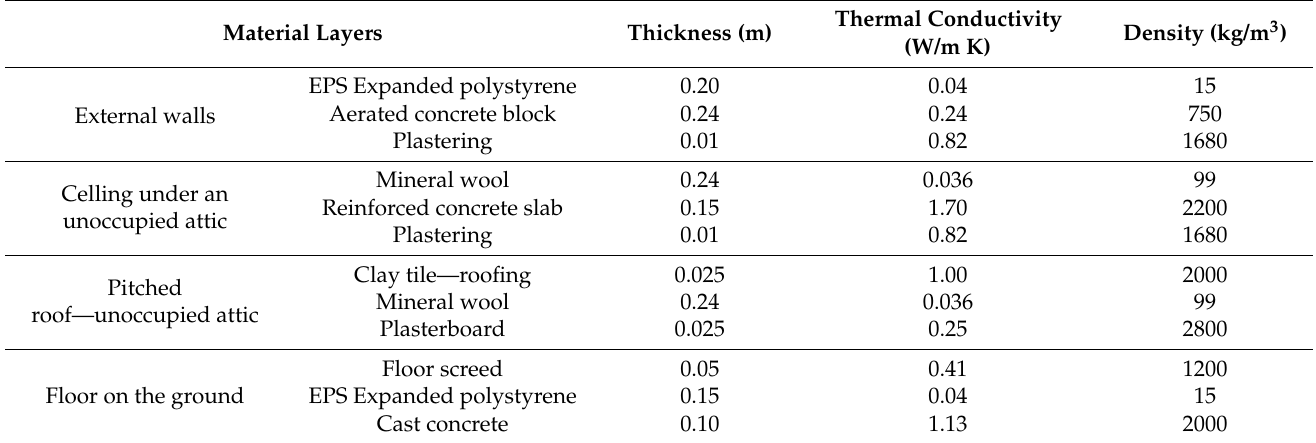
Table 2. Thermal properties of materials of components in the buildings being